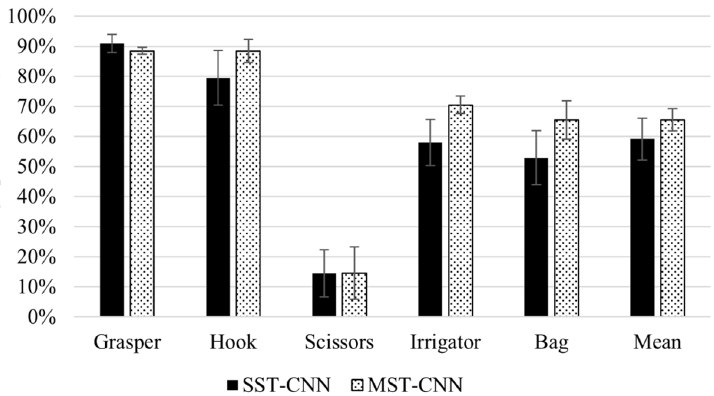
Figure 12. Generalisation performance of four CNN architectures using single-site and multi-site training. The figure shows the mean and standard deviation of average precision with the DenseNet-121, EfficientNet-B0, ResNet-50, and VGG-16 models.